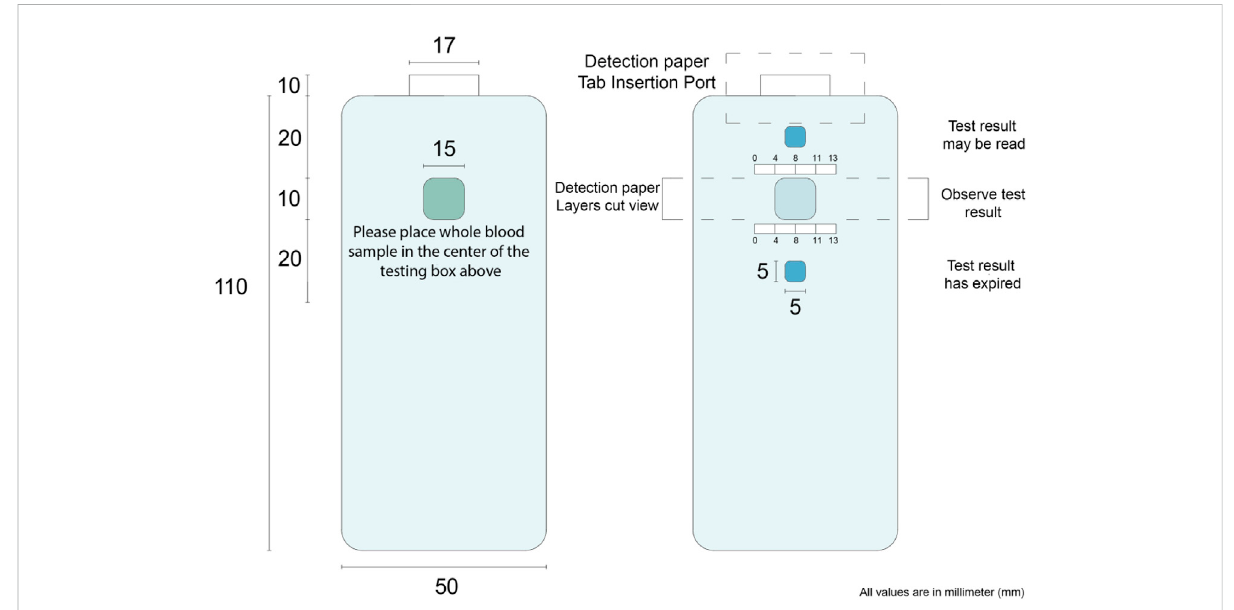
FIGURE 8 Nanocellulose sensor device concept. The numbers on the image represent the distance in mm. These are designed for user friendly